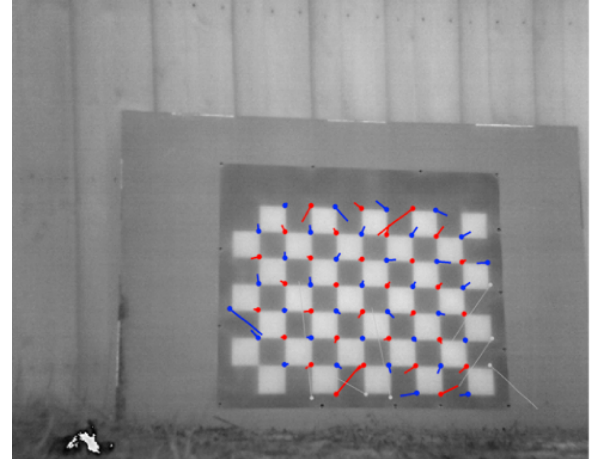
Figure 5. Calibration target, black and white with distortion vectors (84x112cm).